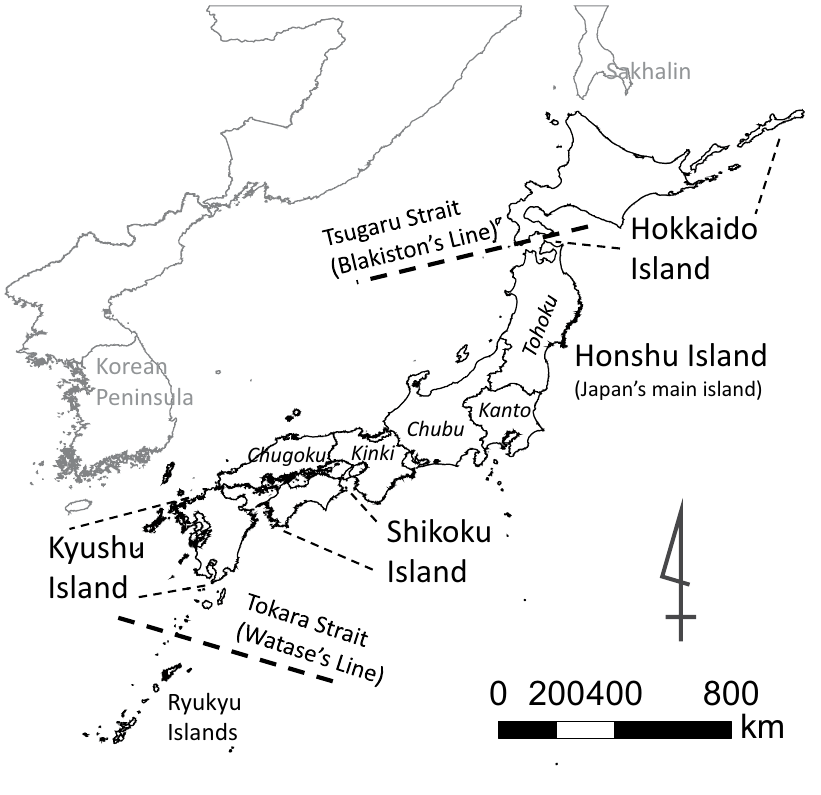
Figure 3. Map of the Japanese archipelago showing the Chugoku, Kanto, Kansai, Kyushu and Tohoku regions as well as the main islands and